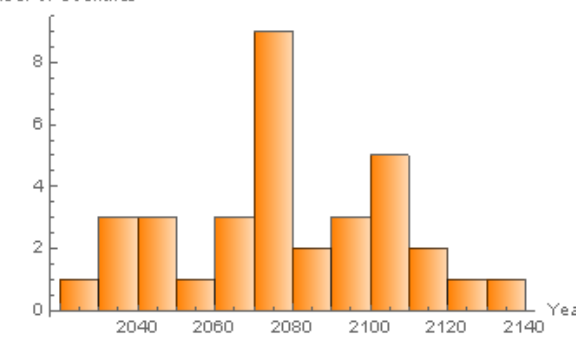
Figure 3. Histogram of years of 95% market adaptation by ZEBs (all EU countries included) [own study].